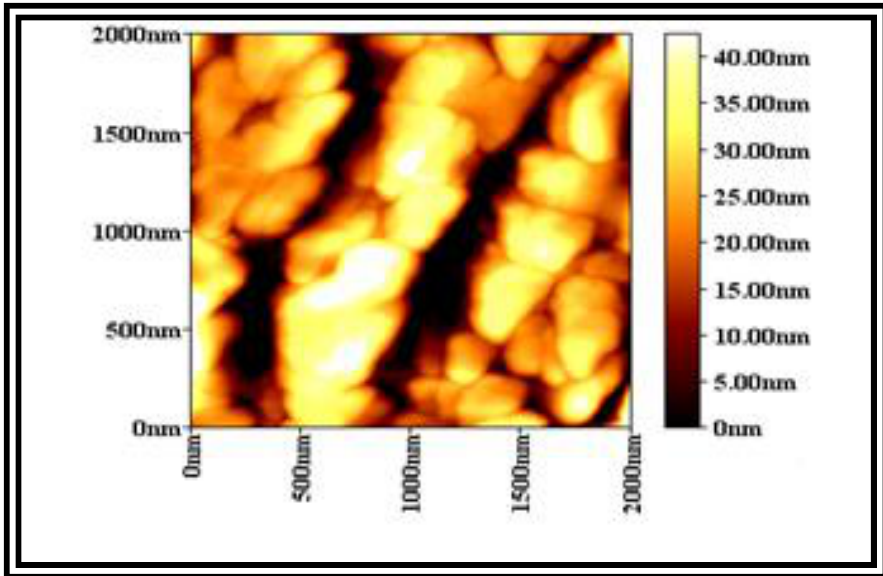
Fig(4a): AFM Topography image of copper oxide thin